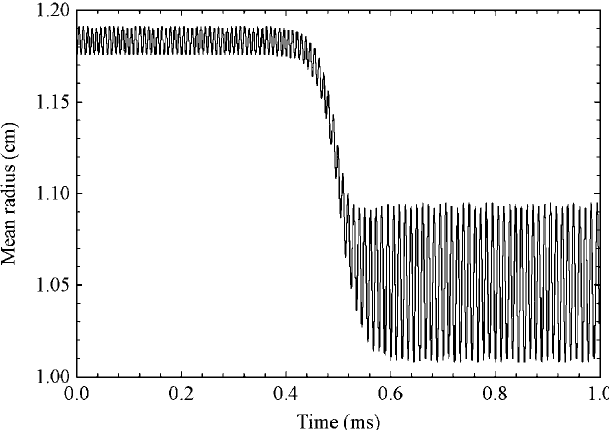
p FIG. 7. The mean radius (cid:1)(cid:1)(cid:1)(cid:1)(cid:1)(cid:1) ab decreases as an adiabatic de- crease in the frequency _ (cid:7) (cid:6) t (cid:7) = 2 (cid:1) from 60 to 45 kHz made over 5 initial lattice periods, (cid:9) (cid:3) 5 (cid:2) (cid:6) 60 kHz (cid:7) (cid:1) 1 , compresses the charge bunch. The compression is more than in the instantaneous-change case, and the mean radius oscillations correspond to a beam that is still well